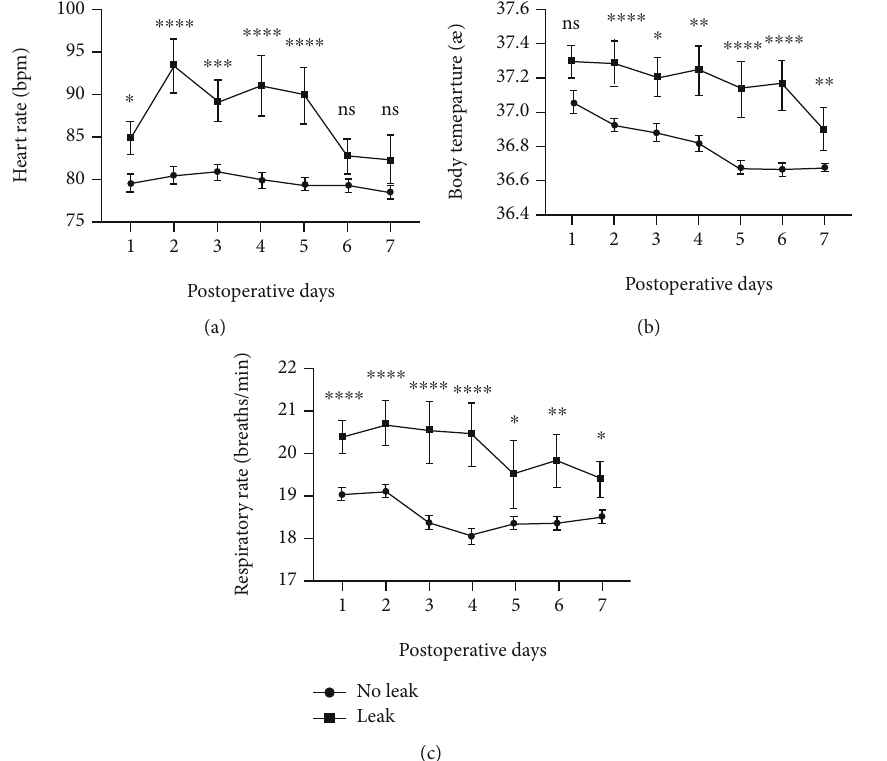
Figure 1: Mean levels of heart rate (a), body temperature (b), and respiratory rate (c) and relative error bars on days 1-7 after surgery.